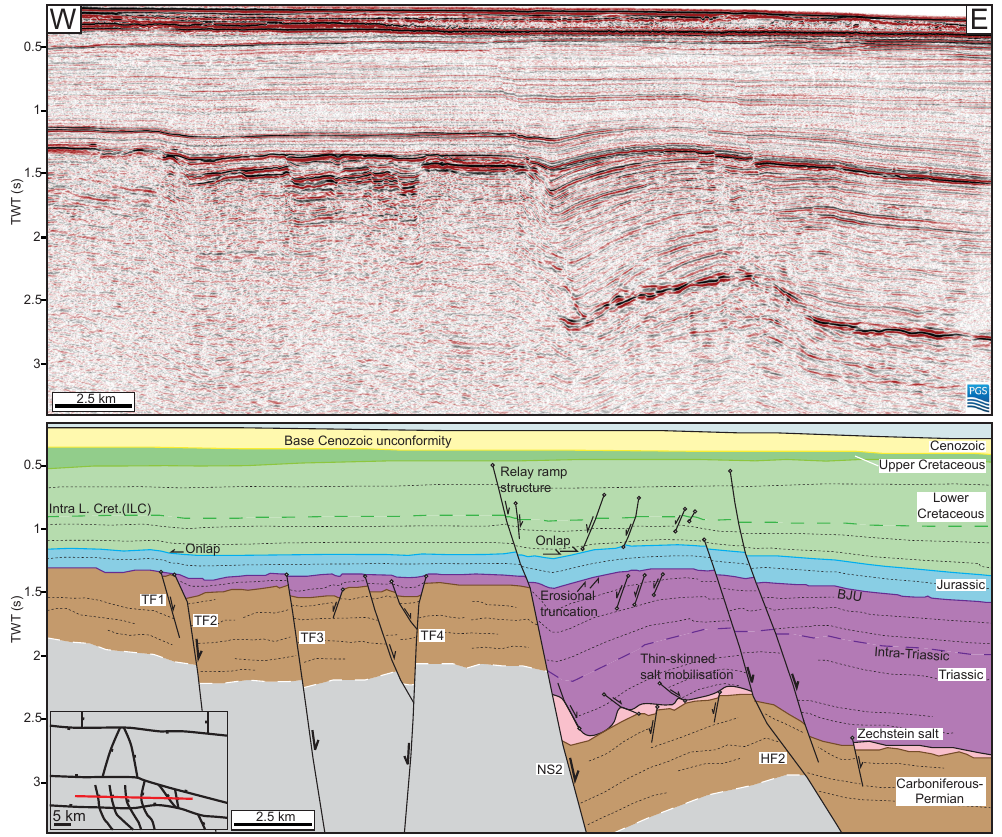
Figure 5. Uninterpreted and interpreted E–W-oriented seismic section (taken from 3-D volume) across the Farsund Basin. Triassic thickness changes are observed across N–S-striking faults, with other stratigraphic intervals appearing largely isopachous. See Fig. 1c for